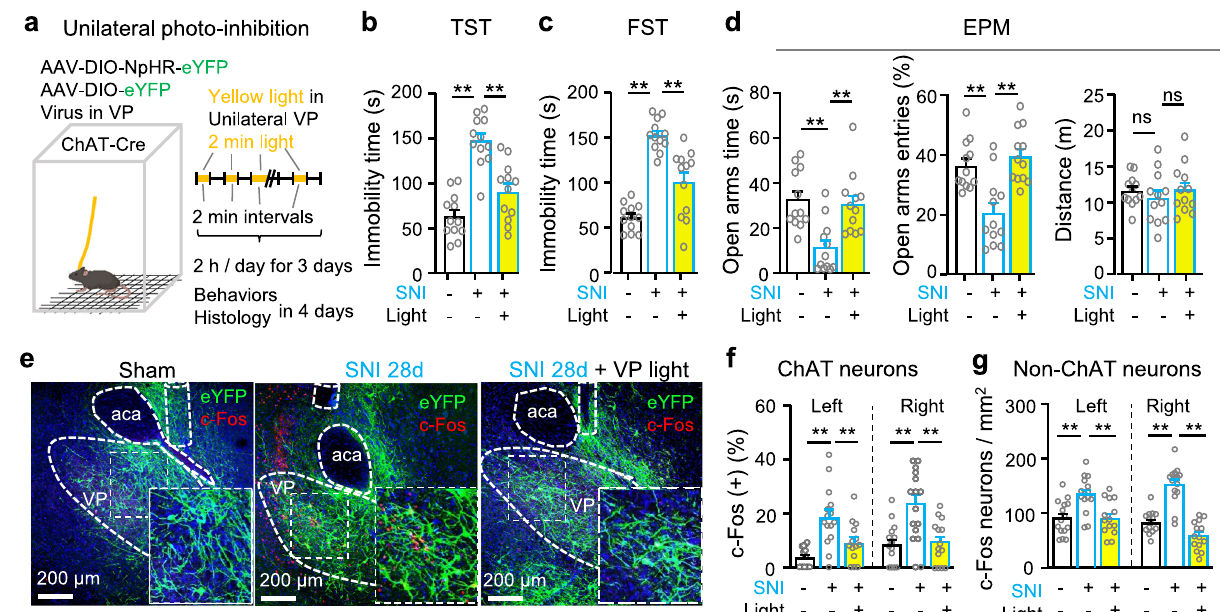
Fig. 7 | Repetitive photoinhibition of VP ChAT neurons mitigates depression- and anxiety-like behaviours in persistent pain. a – d Schematic diagram for repetitiveoptogeneticinhibitionofVPChATneuronsandbehaviouraltestsinsham ( n =12), SNI ( n =12), SNI-VP-light ( n =12) mice. b TST. F (2, 33) =27.86, P <0.0001. t =7.32,df=33, P <0.0001,ShamvsSNI; t =4.94,df=33, P <0.0001,SNIvsSNI-VP- light. c FST. F (2,33) =39.43, df=33, P <0.0001. t =8.85, df=33, P <0.0001, Sham